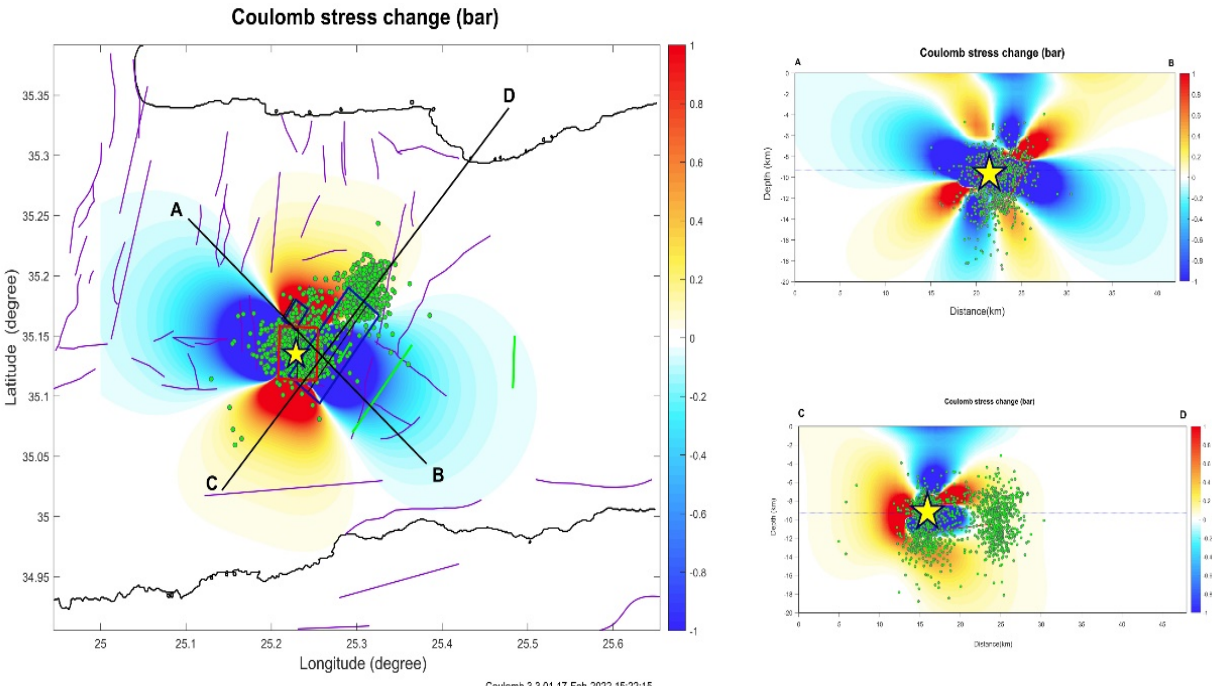
Figure 14. ( Left ) Coulomb stress changes distribution due to Mw = 5.4 major aftershock (yellow star) at centroid depth of 9.0 km. The red rectangle indicates the fault model for the kinematics of Mw = 5.4, while the blue ones are the projections of the fault models of Mw = 4.9 and Mw = 6.0 events (listed in Table 3). ( Right ) Coulomb stress changes along the cross-sections AB, CD. The green circles are the relocated hypocenters of the aftershocks which occurred after the Mw = 6.0 main shock. The green lines show the surface projections of the two fault models.